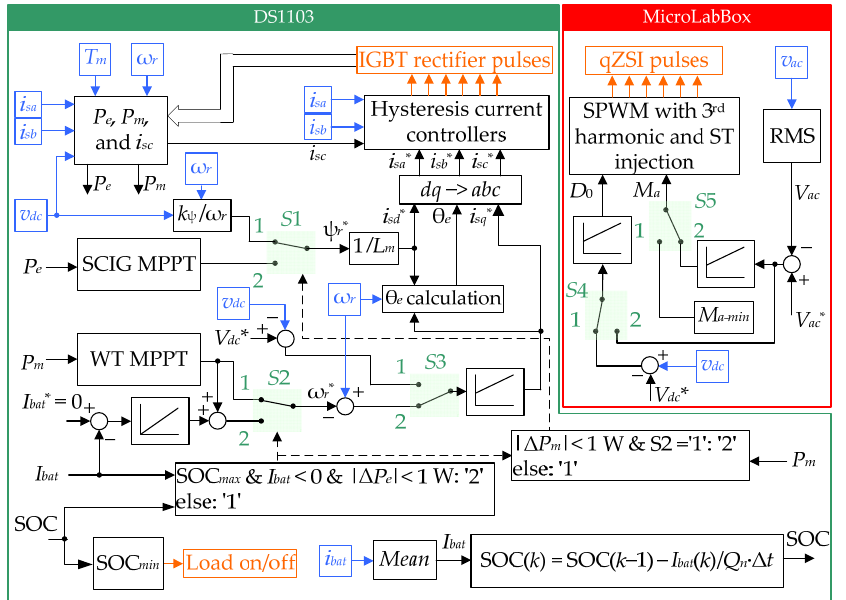
Figure 2. Proposed control algorithms: DS1103-executed part (in green; indirect-rotor-field-oriented control (IRFOC), maximum power point tracking (MPPT), and state of charge (SOC) management) and MicroLabBox-executed part (in red; V dc and V ac control).